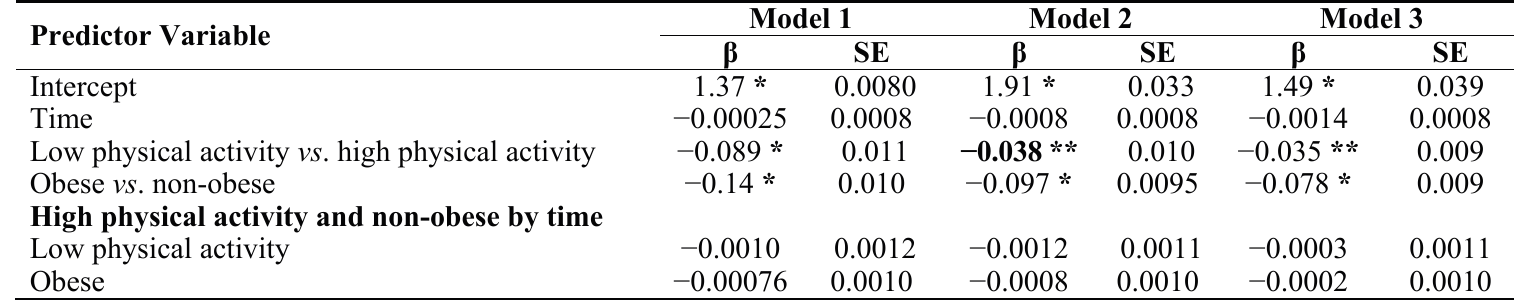
Table 2. General linear mixed models estimate for gait speed as a function of physical activity (PA) levels and obesity status over 6 years in older adults with frequent knee pain ( N = 1788).